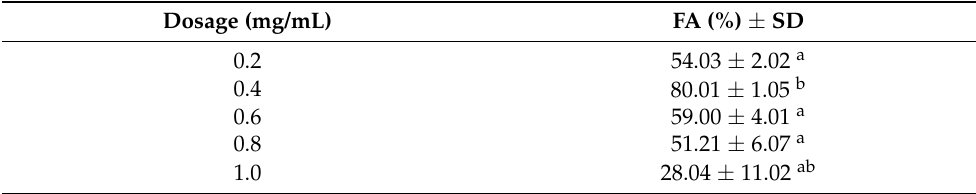
Table 3. Effect of dosage on flocculation.